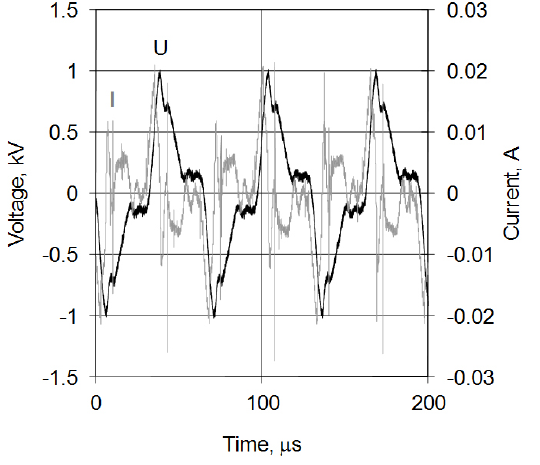
Figure 4 : Traces of pulses voltage and current for the spark reactor.